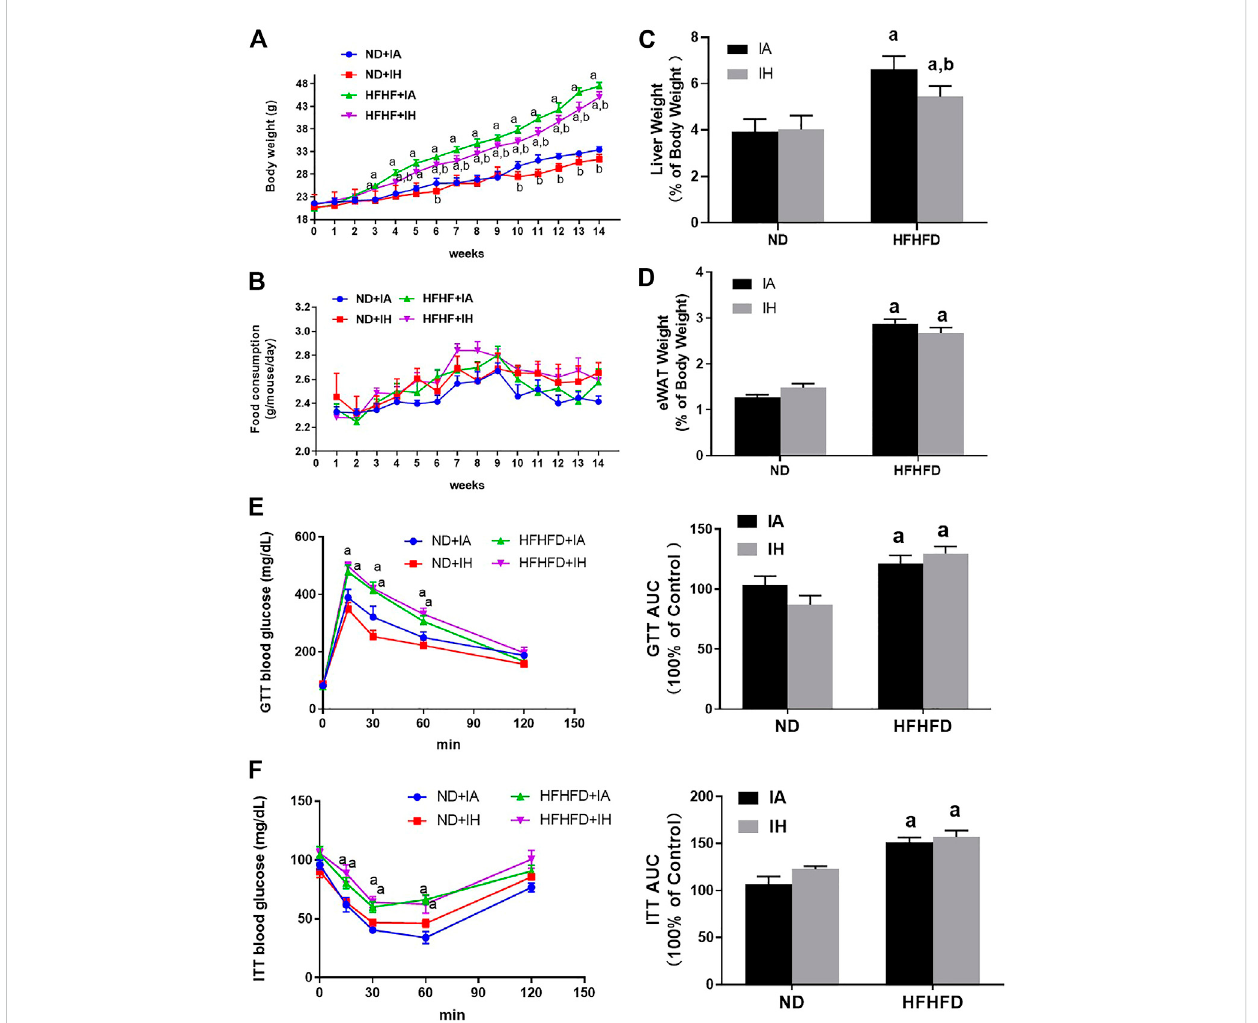
FIGURE 2 Metabolicphenotype. (A) Thebodyweightofmiceforallgroupswasmonitoredonceperweekandisdepictedfor15 ° weeks. (B) Foodconsumption wasmeasuredtwiceperweekduringthe15-weekexposureperiod. (C,D) LiverweighttobodyweightratiosandeWATweighttobodyweightratioswere calculated for each group at the 15th week. (E,F) Glucose tolerance tests (GTT) and insulin tolerance tests (ITT) were performed and the area under the curve (AUC) was calculated. a, p < 0.05 compared to ND control, b, p < 0.05 compared to absence of IH. Samples size per group n = 4 –